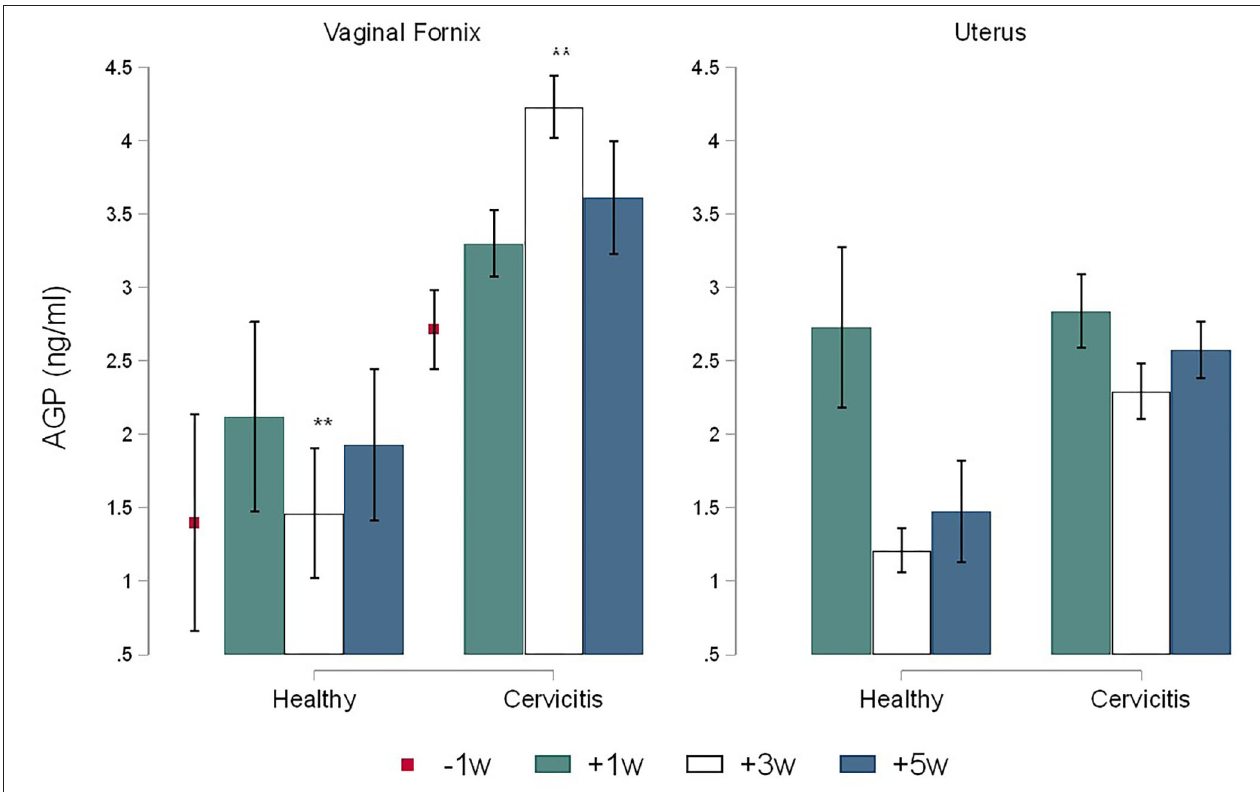
FIGURE 5 | Time-course variations (Mean ± SEM) in pre-and post-partum concentrations of AGP in the vaginal fornix and uterine mucus of cows ( n = 26) defined as clinical cervicitis cows ( n = 19) and healthy cows ( n = 7) from three dairy herds in Quebec in 2016. Time-course variations (weeks − 1w + 1w + 3w + 5w) of α 1-acid glycoprotein (ng/ml) concentrations (Mean ± SEM). An asterisk indicates a significant difference at p ≤ 0.05 (*) or p ≤ 0.01 (**) for the Mann-Whitney Test (Ha: clinical cervicitis cows 6= healthy